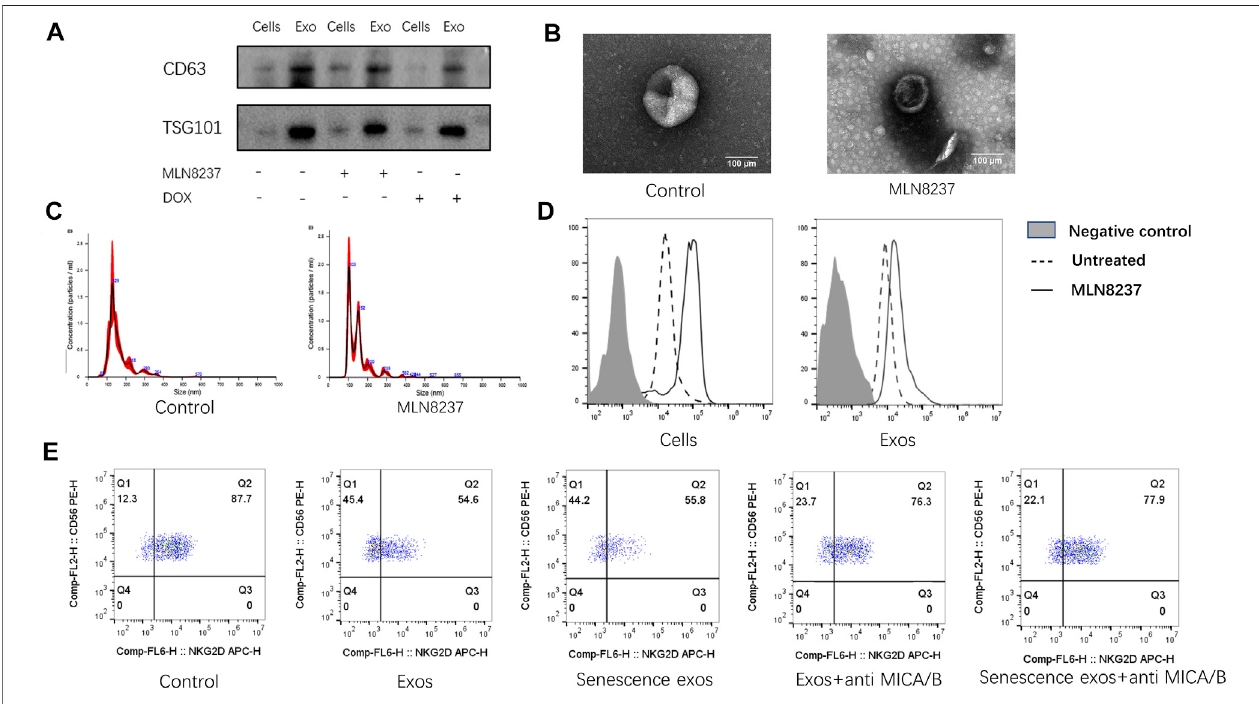
FIGURE 2 | Inhibition of NKG2D expression by exosomal MICA/B. (A) IMR-32 cells were treated with 2 μ M MLN8237 or 0.5 μ M DOX for 72 h. No treatment was used as a control, and exosomes were isolated by ultracentrifugation. Western blot was used to evaluate CD63 and TSG101 levels in whole cell lysates of the cells or isolated exosomes from supernatants. (B) Representative EM image of exosomes and showing the typical cup-shaped morphology. Scale bar, 100 nm. (C) Analysis of particle size distribution and concentration in exosomes. (D) IMR-32 cells were treated with 2 μ M MLN8237 for 72 h, no treatment was used as a control. The expression of MICA/B in IMR-32 cells and exosomes were determined by fl ow cytometry, and exosomes were pretreated by coated latex microbeads. (E) Normal humanperipheralbloodNKcellswereusedasacontrol.Exosomesisolatedfrom untreated IMR-32cells, andMLN8237-treatedcellswereco-culturedwithNKcellsfor 24 h. Co-cultures were spiked with the MICA/B antibody, and NKG2D expression was detected by fl ow cytometry.